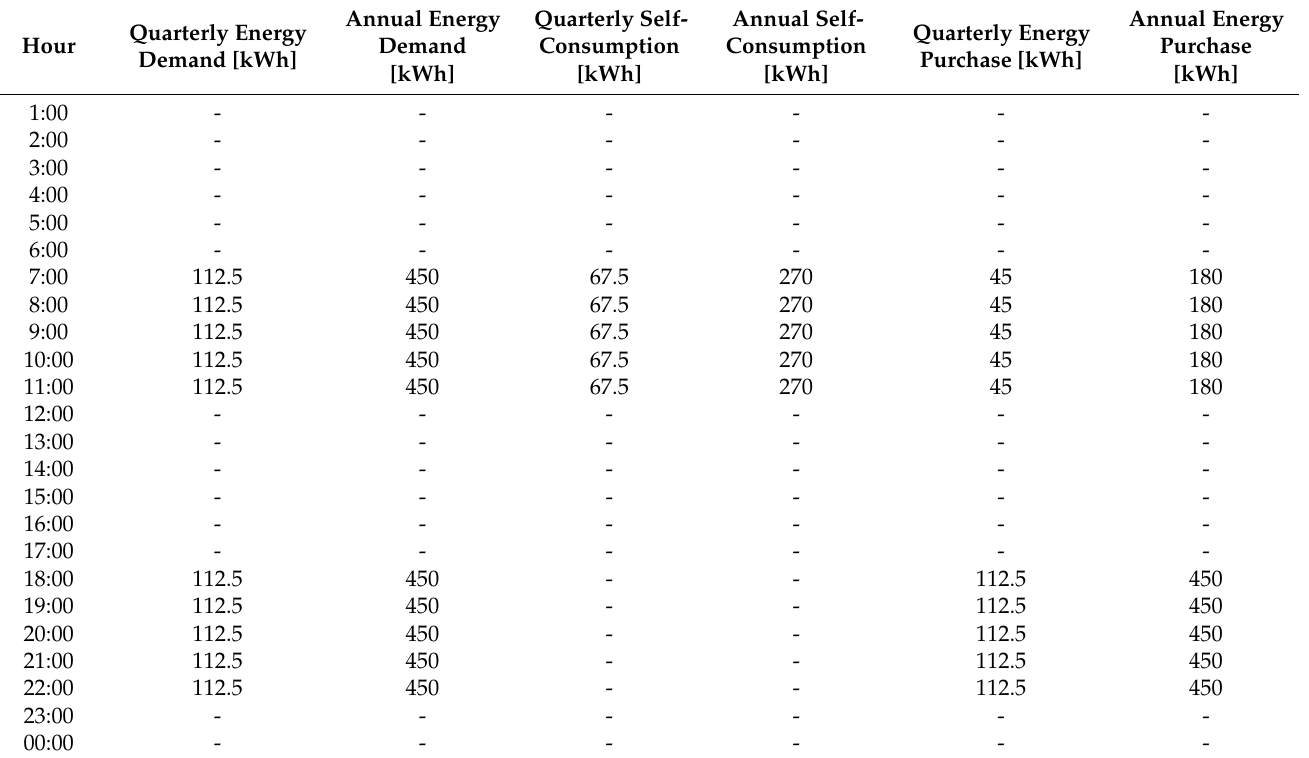
Table 6. An hourly profile of the household, which takes into account energy demand, self- consumption, and energy to be purchased on a quarterly and annual basis during the spring and summer periods.